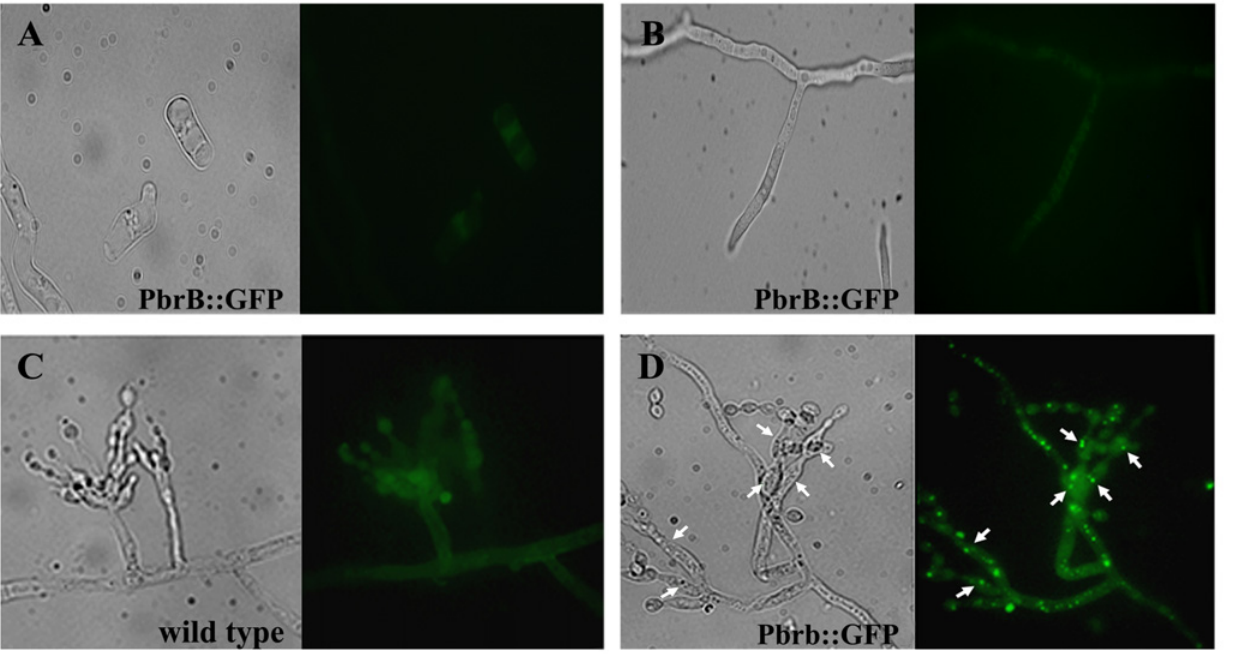
Fig 3. Expression and localization of PbrB in T . marneffei . Epifluorescence microscopy of the T . marneffei strain expressing the PbrB::GFP fusion in vegetative cells grown at 37°C (A) or 28°C (B) for 3 days. No GFP fluorescence was noted in either cell type. Epifluorescence microscopy of the T . marneffei conidiophores from the wild type (G681) strain (C) and the strain expressing the PbrB::GFP fusion (D) under bright field and fluorescence optics. The PbrB:: GFP fusion is observed as distinct spots (white arrows) in metulae and phialides. Strains were grown on slides at 28°C for 10 days. Microscopic images were captured at 1000X